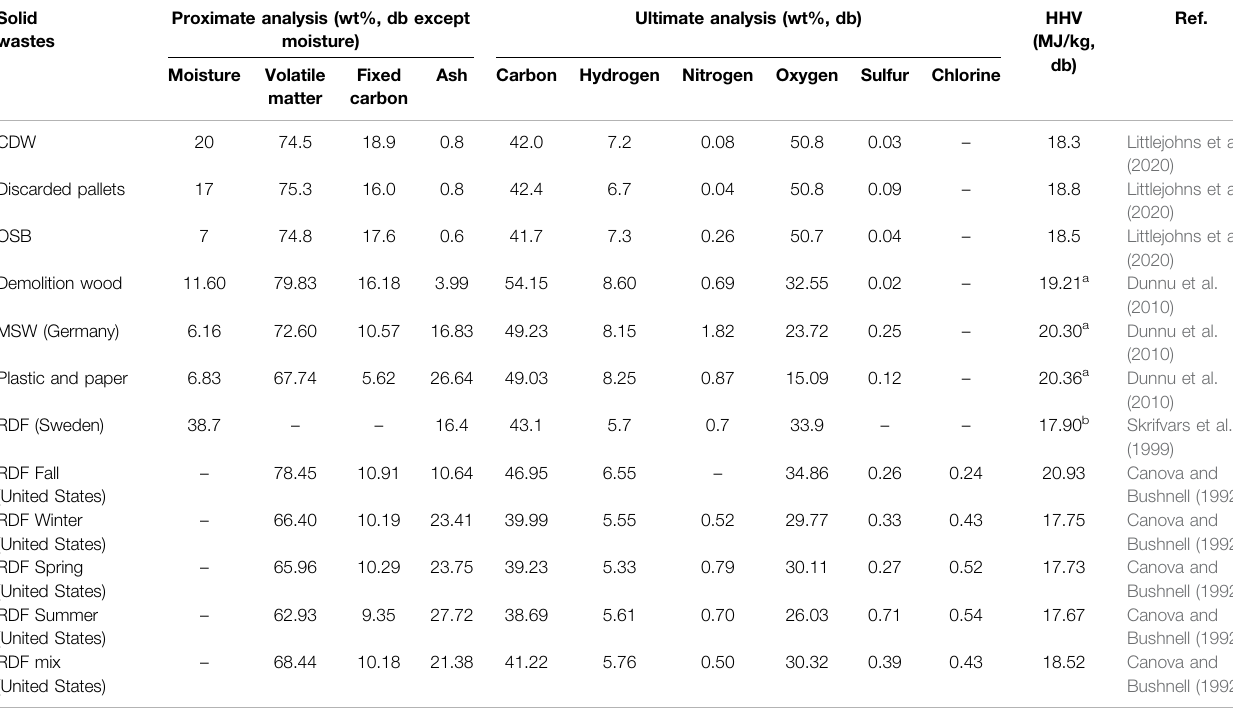
TABLE 2 | Summary of higher heating values, proximate and ultimate analyses of solid waste samples from the literature. Solid